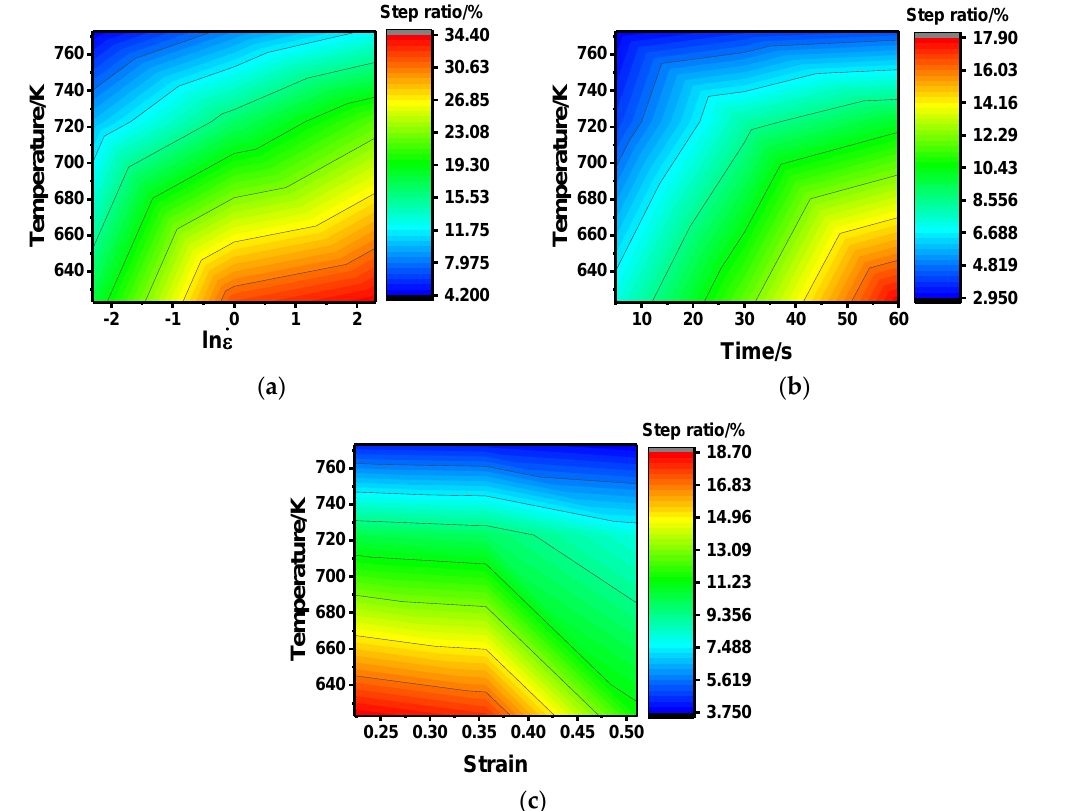
. ε , ( b ) time, , ( b ) time, ln ε̇